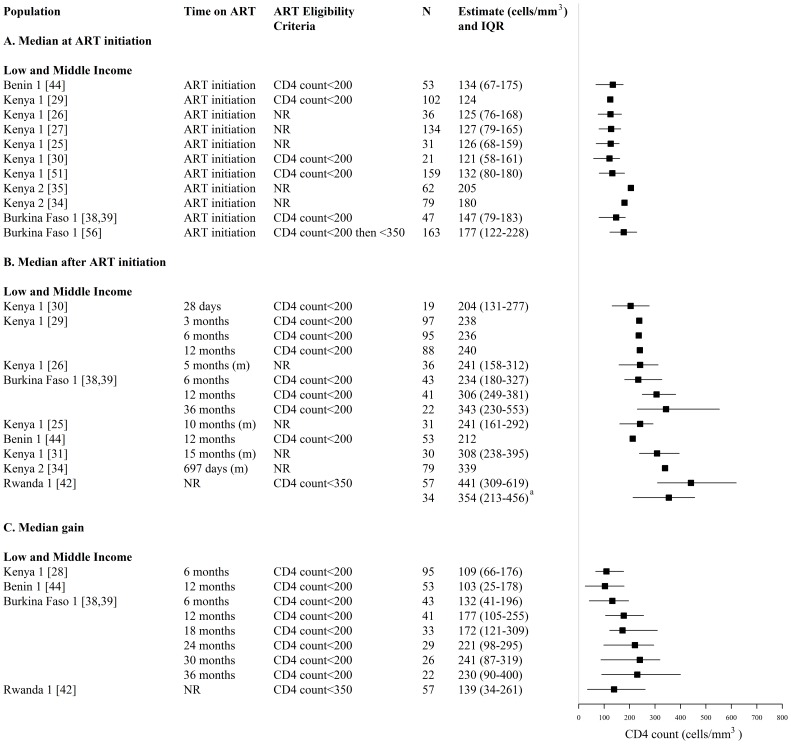
Forest plot of (A) median CD4 count and (B) median gains in CD4 count among HIV-infected FSWs on ART and starting ART.Study estimates are grouped by country income and ordered by time on ART. a N refers to a subset of FSWs who were eligible for ART upon HIV diagnosis and enrolled in HIV care following HIV diagnosis. ART  =  antiretroviral, FSW  =  female sex workers, CI  =  confidence interval, NR  =  not reported, N =  sample size of FSWs available for each outcome, Np =  number of independent study populations, m =  median, IQR  =  interquartile range.